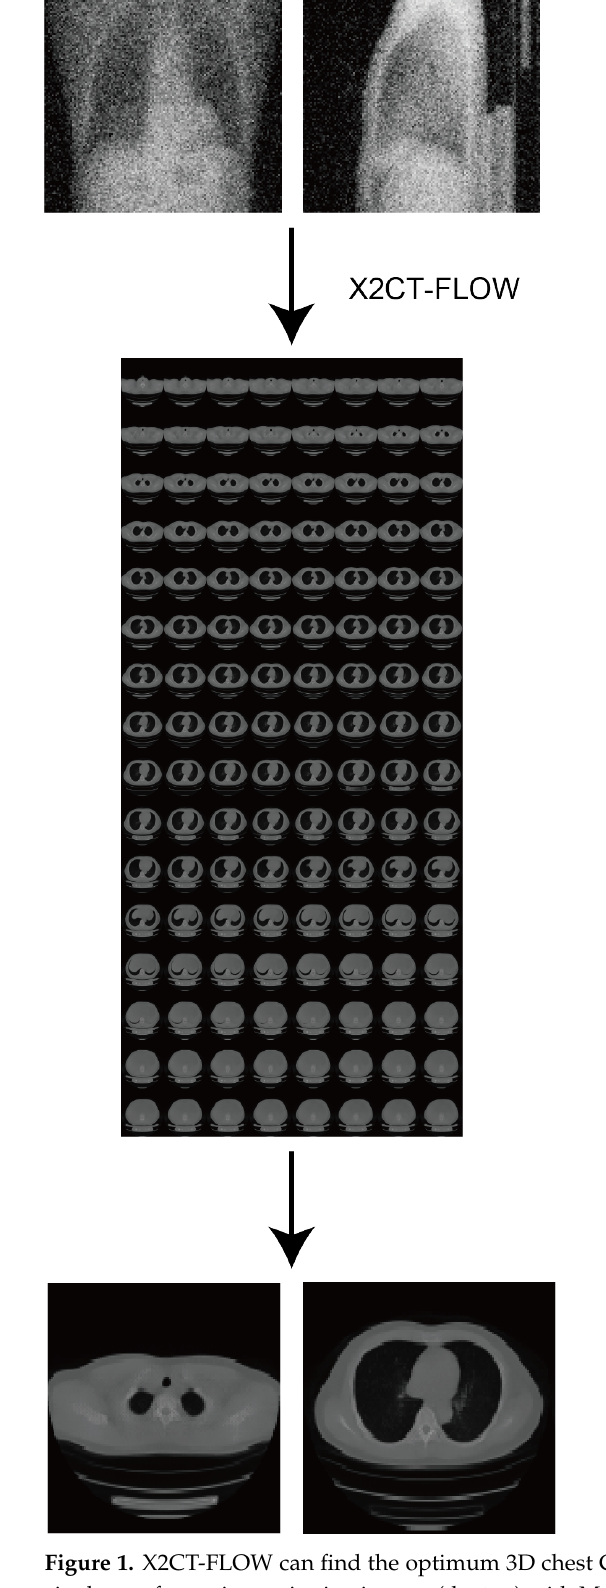
Figure 1. X2CT-FLOW can find the optimum 3D chest CT image (the middle and bottom ) from a single or a few noisy projection images (the top ) with MAP reconstruction. Scales of the images are not the